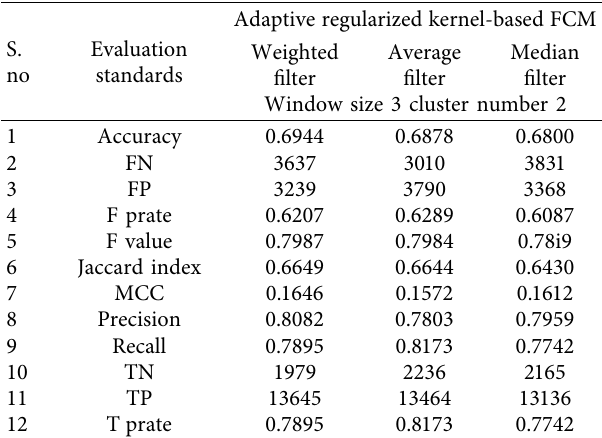
Table 2: Evaluation